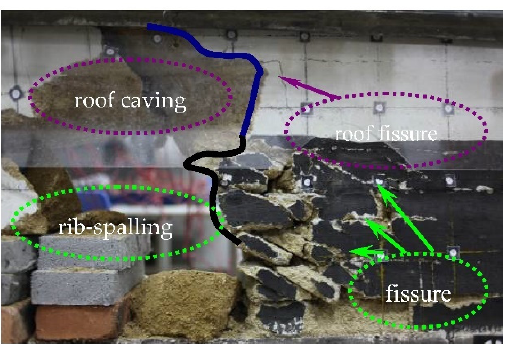
Figure 13. Development of joint and instability form the coal wall rib-spalling ( α = 150°).